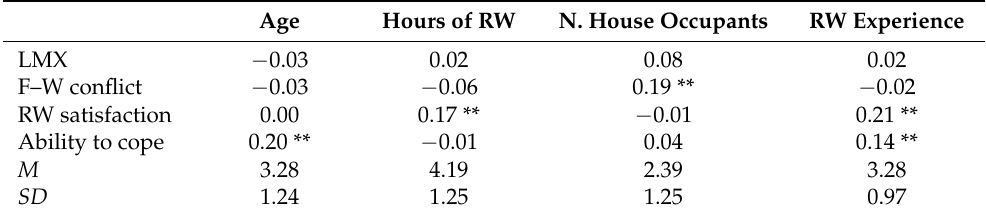
Table 2. Descriptive statistics and Spearman’s correlations of the study variables with the ordinal control variables. Age Hours of RW N. House Occupants RW